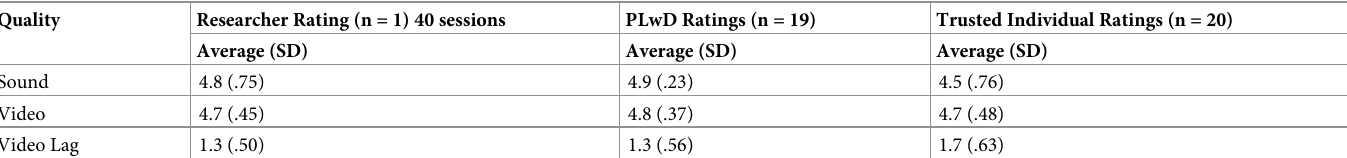
Table 2. Researcher and participants’ experiences of virtual modality.